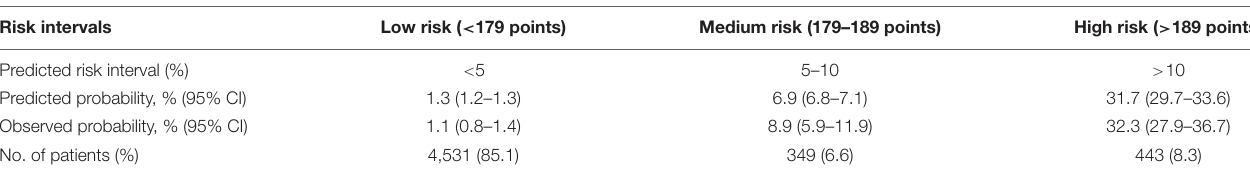
FIGURE 3 | The ROC curves and the AUCs of the other ten models and the six independent risk factors for severe hypoxemia after cardiac surgery. AUC, area under the receiver operating characteristic curve; CI, confidence interval; ROC, receiver operating characteristic curve. TABLE 3 | Risk intervals of SH based on the nomogram and clinical